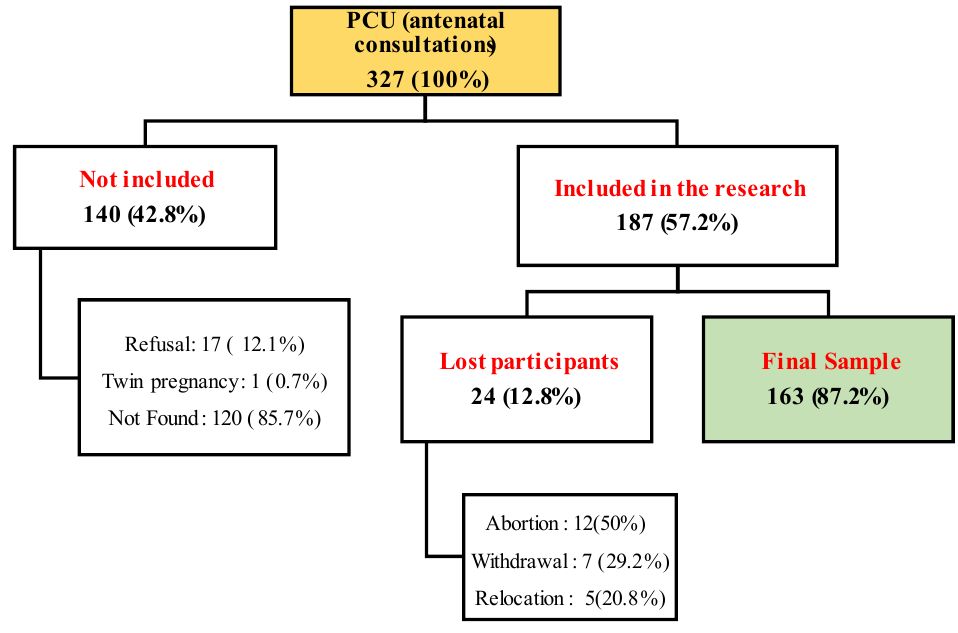
Figure 1. Selection flowchart of the population study.